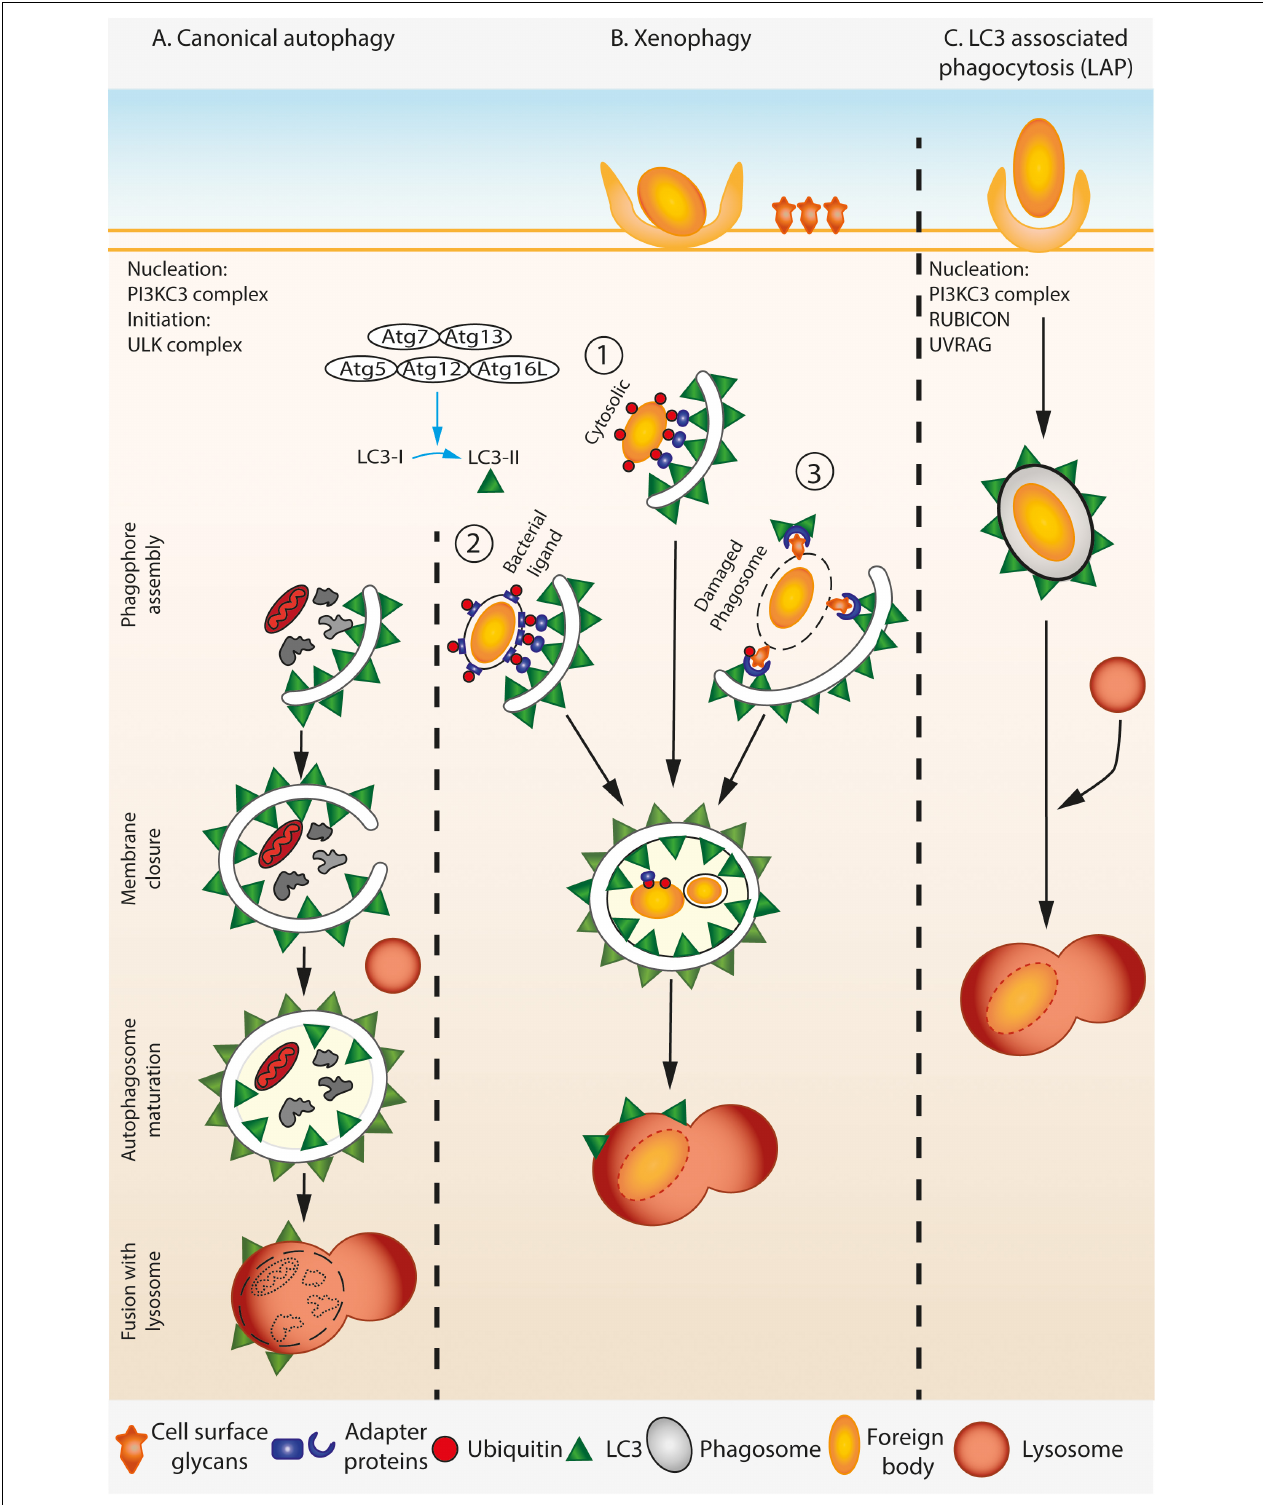
FIGURE 1 | A simplified overview of canonical autophagy, xenophagy, and LAP. (A) During canonical autophagy, the nucleation and initiation complexes orchestrate the assembly of phagophore. LC3 is processed and lipidated by covalent conjugation of phosphatidylethanolamine (PE) to its C-terminal Glycine by ATG complex.